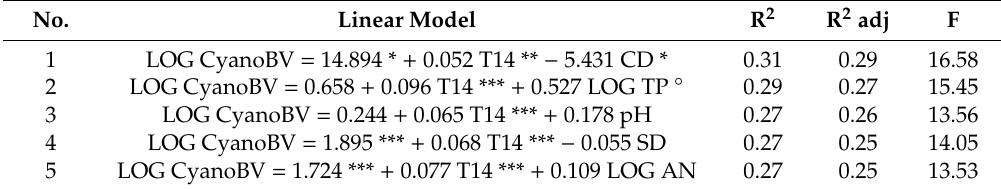
Table 3. Multiple linear regression (MLR) models of cyanobacteria biovolume (LOG CyanoBV) using the 14-days mean air temperature (T14) and one of the physical–chemical variables listed in Table S1 of SI (AN: Ammonium nitrogen; CD: Conductivity; TP: Total phosphorous; SD: Secchi disk depth; and pH). The statistical significance of each coefficient is indicated when below 0.1 ( p -values: ***: 0.001; **: 0.01; *: 0.05; °, 0.1). For each model the coefficient of determination (R 2 ), the adjusted R 2 (R 2 adj), and the F statistic are reported. LOG means ten-based logarithm.